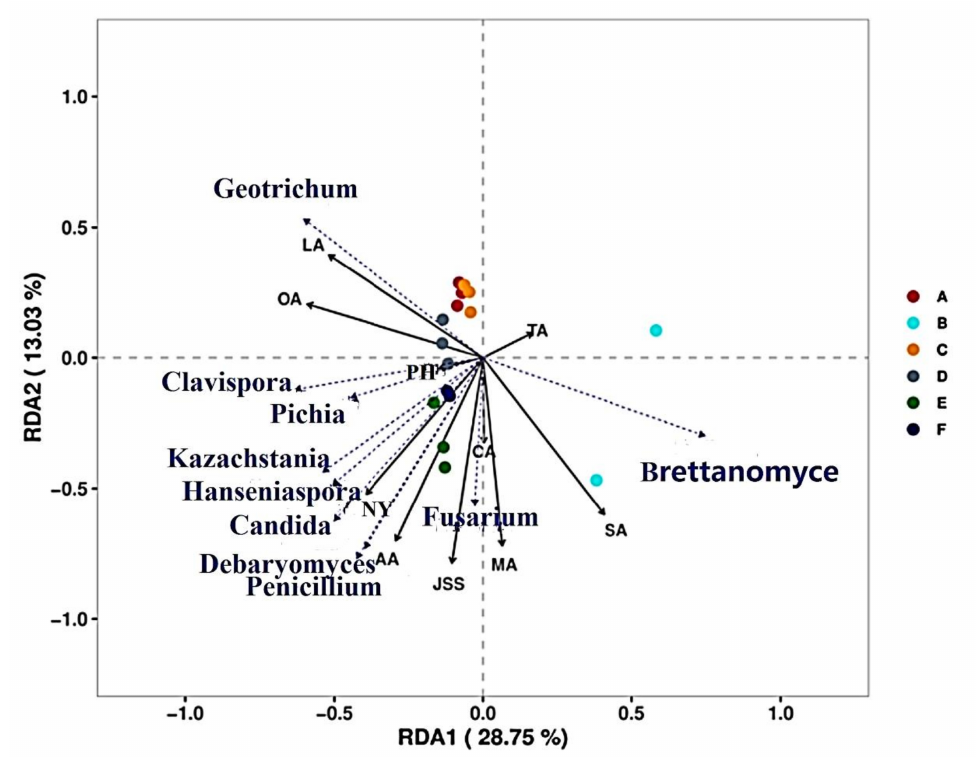
Figure 7. Correlations between RDA (OTU > 0.1%) and physicochemical indices for fungi. (A–F)